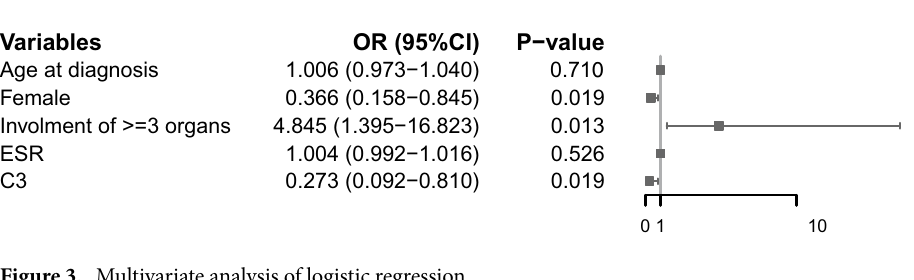
Figure 3. Multivariate analysis of logistic